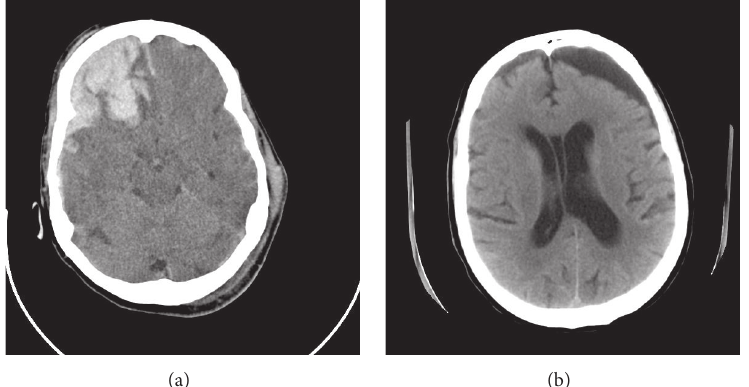
Figure 3: (a) Image 2: CT head cerebral contusion, and (b) Image 3: CT Head Chronic SDH (Image Courtesy: http://lifeinthefastlane.com/